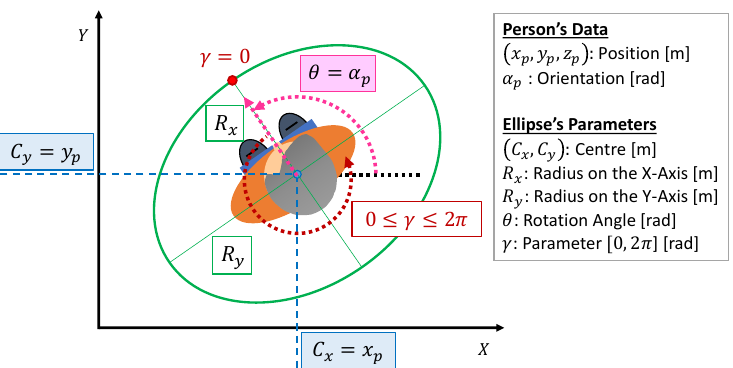
Figure 4. Variables of the parametric equation of the ellipse centred at the XY position of the person and rotated according to their orientation.